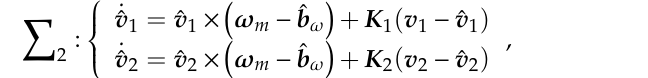
(cid:80) and linear  1 and linear 1